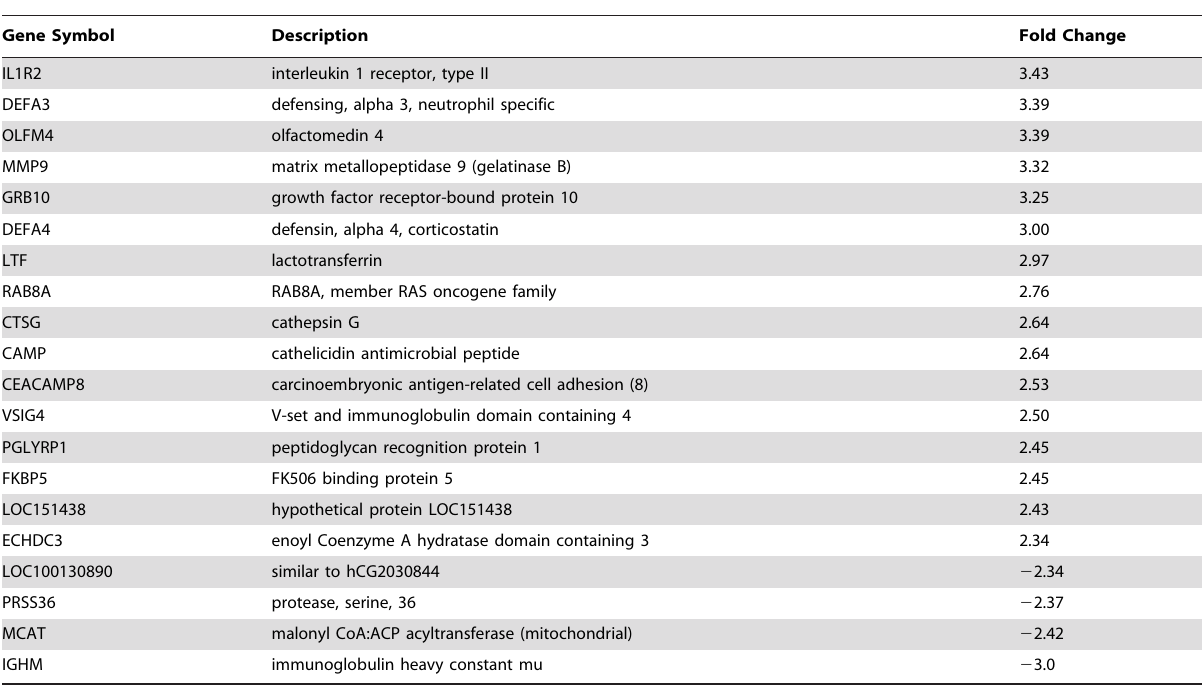
Table 4. Differentially-expressed genes that distinguish severe IPF from control.